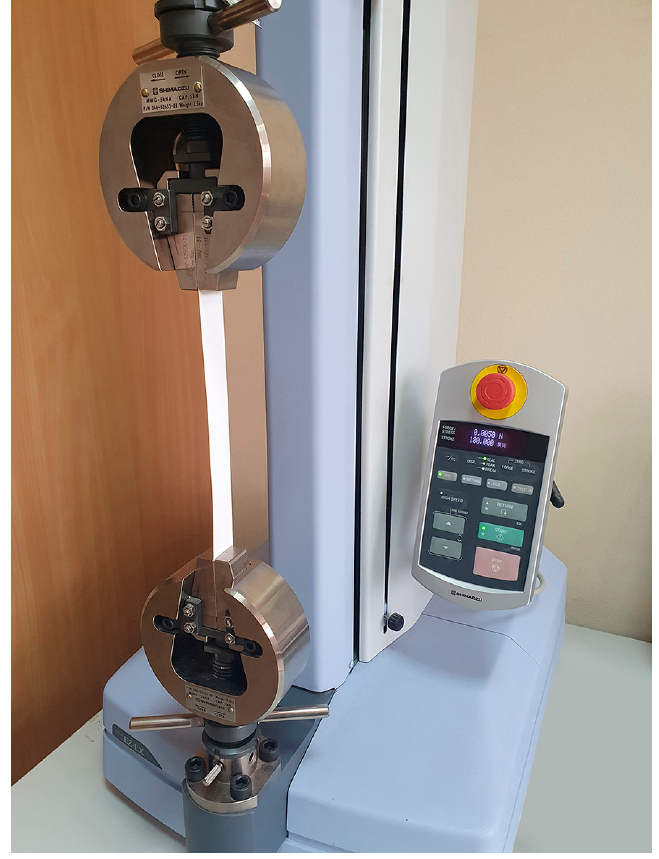
Figure 4. Tensile strength testing.